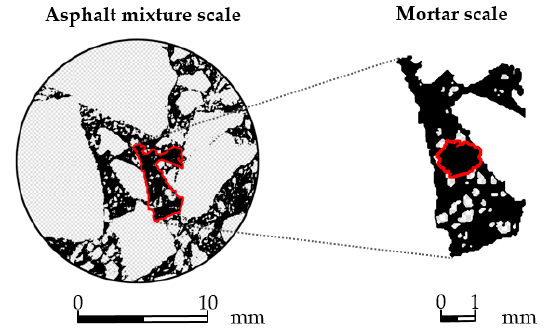
Figure 1. Asphalt mixture bonded by asphalt mortar.